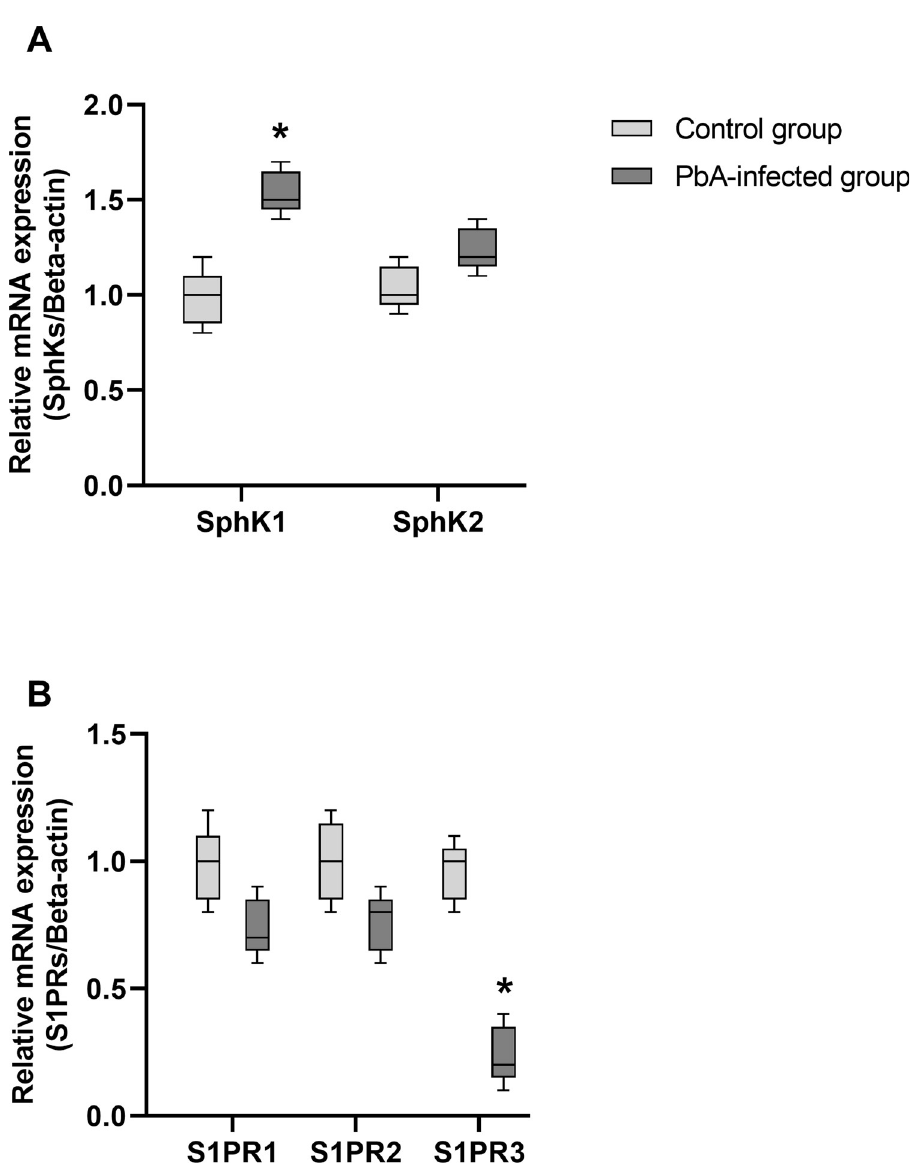
Fig 3. Relative SphK and S1PR mRNA expression as measured by real-time PCR. Data are presented as the mean ± SD of triplicate experiments. � p < 0.05 compared with the control group.